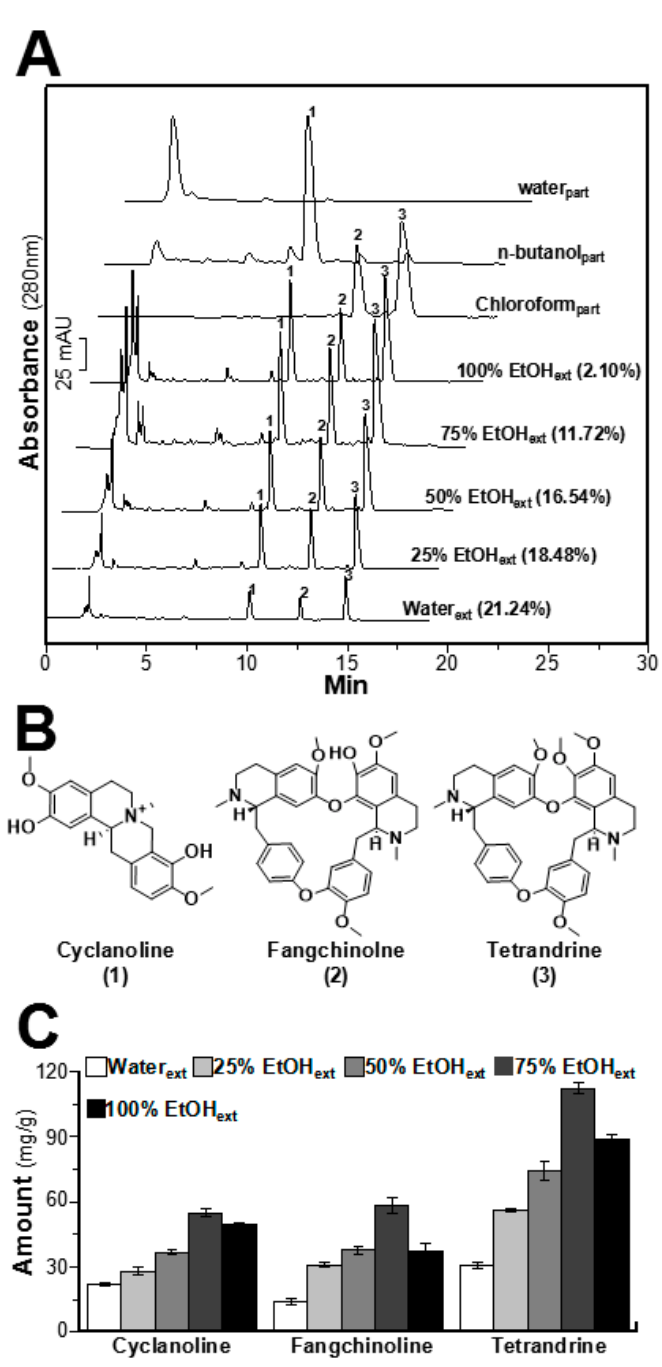
Figure 1. The HPLC chromatograms of di ff erent Stephaniae tetrandrae radix (STR) extracts and structures of STR alkaloids. ( A ) The profiles of STR extracts are shown, and the x -axis and y -axis represent retention time (min) and absorbance units (mAU) at 280 nm, repectively. The yields of STR extracts using water and di ff erent fractions of ethanol (25%, 50%, 75%, and 100%) are listed in parentheses beside the chromatogram. The main alkaloids of STR extracts were identified using known chemical standards. The identification numbers of alkaloids in STR extracts are labeled in HPLC chromatograms as follows: 1, cyclanoline; 2, fangchinoline; 3, tetrandrine. ( B ) Structures of alkaloids in STR extracts. The structures are numbered and listed from 1 to 3 according to the HPLC in ( A ). ( C ) Amounts of alkaloids in STR extracts using di ff erent solvents according to HPLC analysis, as in ( A ). Values are the mean ± SEM (standard error of mean) of three dependent determinations.